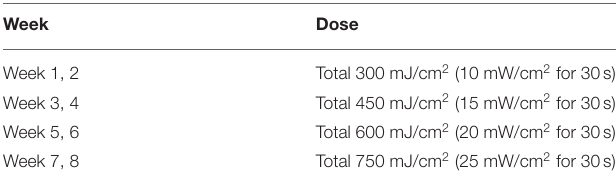
TABLE 1 | Excimer light therapy protocol.